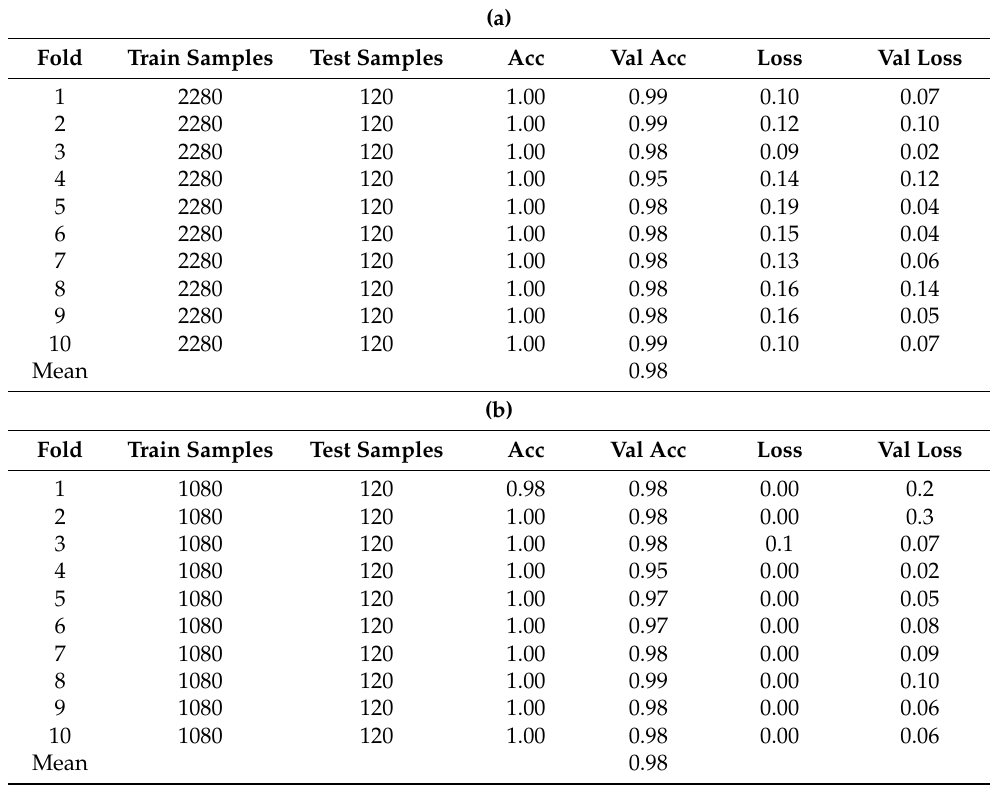
Table 5. ( a ) Results of 10-fold cross validation on augmented heart sound database on GoogleNet. ( b ) 10-fold cross validation result on the original dataset on